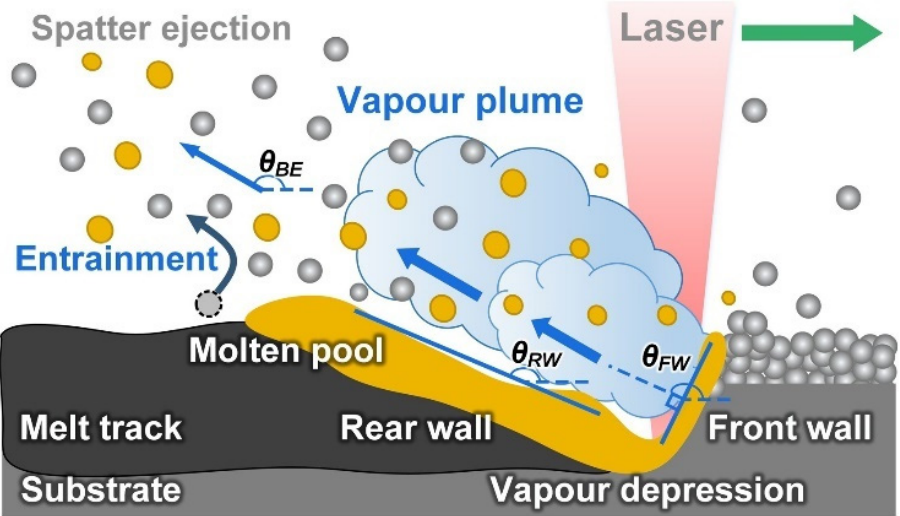
Figure 11. Schematic of the correlation between the depression zone in melt pool and the backward- ejected spatter during L-PBF. The inclined angles for the normal direction of the front depression wall θ FW and the inclination angle of the rear depression wall θ RW had the same trends with the average angle of the backward-ejected spatter ( θ BE ). (Reprinted with permission from Ref. [34]. Copyright 2019 Elsevier B.V.).